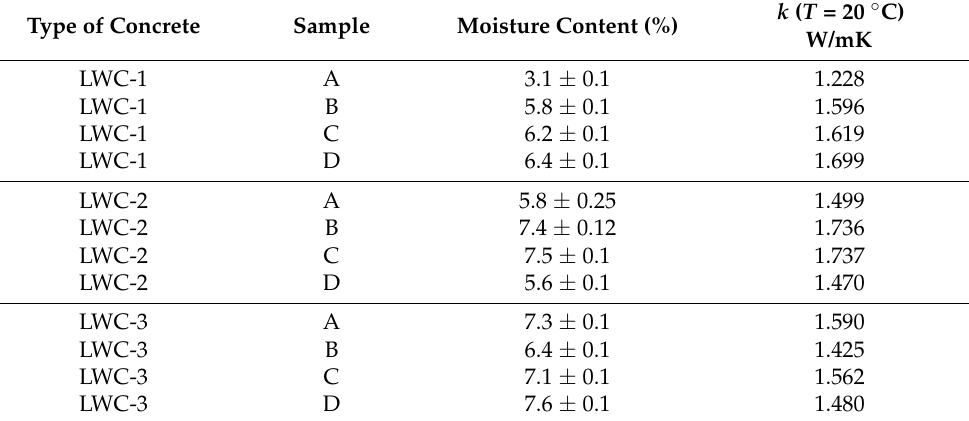
Table 3. Moisture content and average thermal conductivity values of LWC samples at ambient